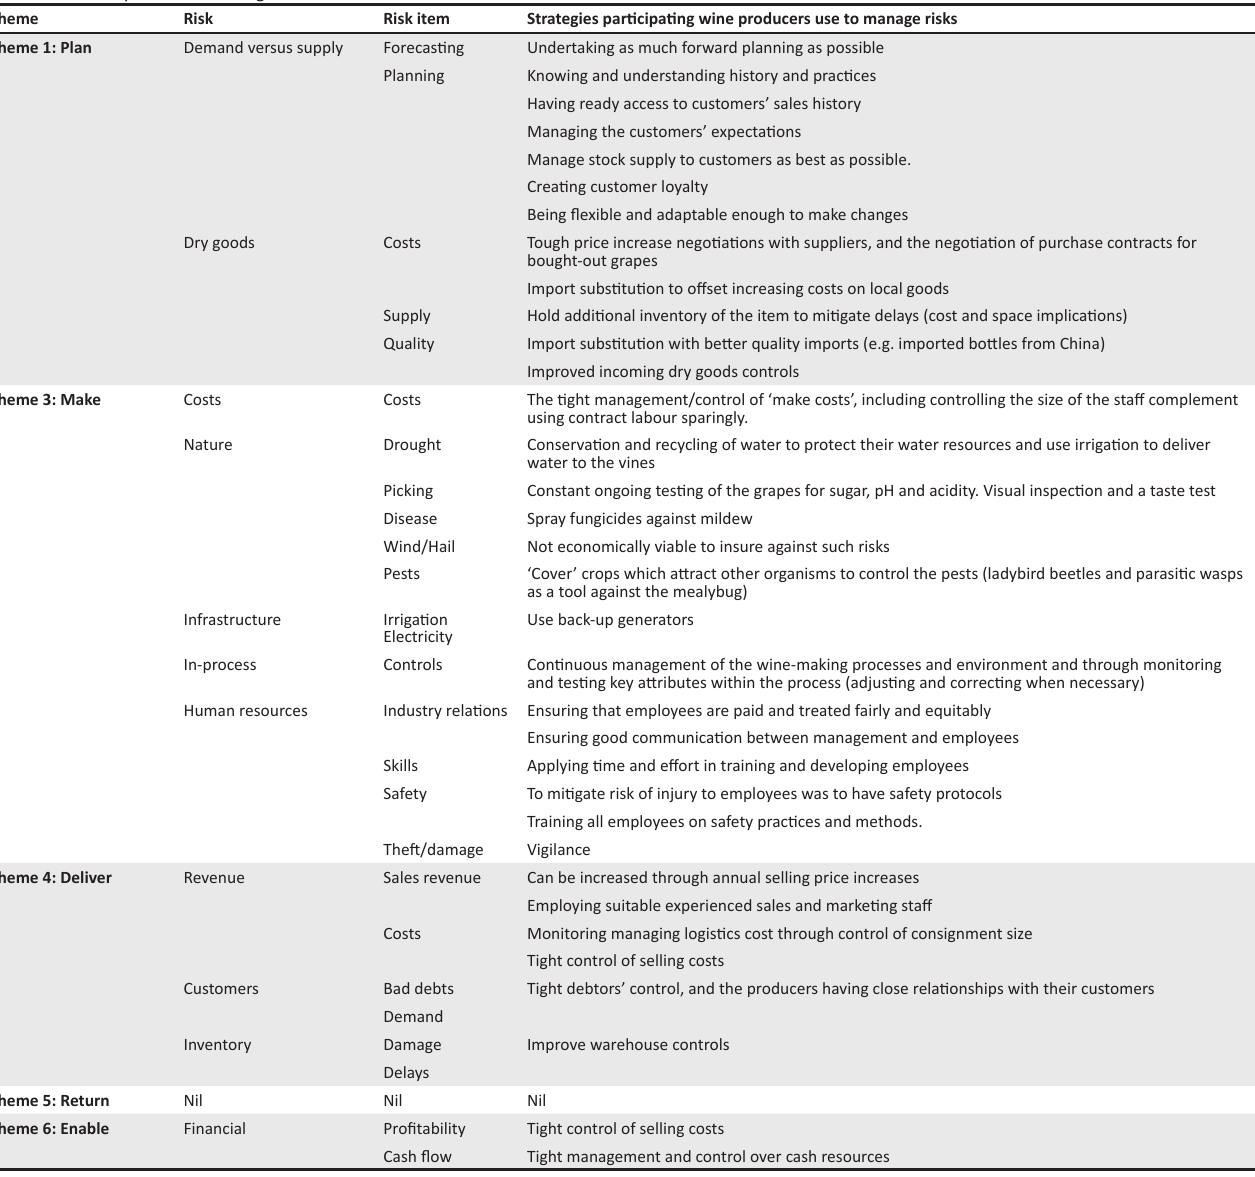
TABLE 6: Summary of risks and